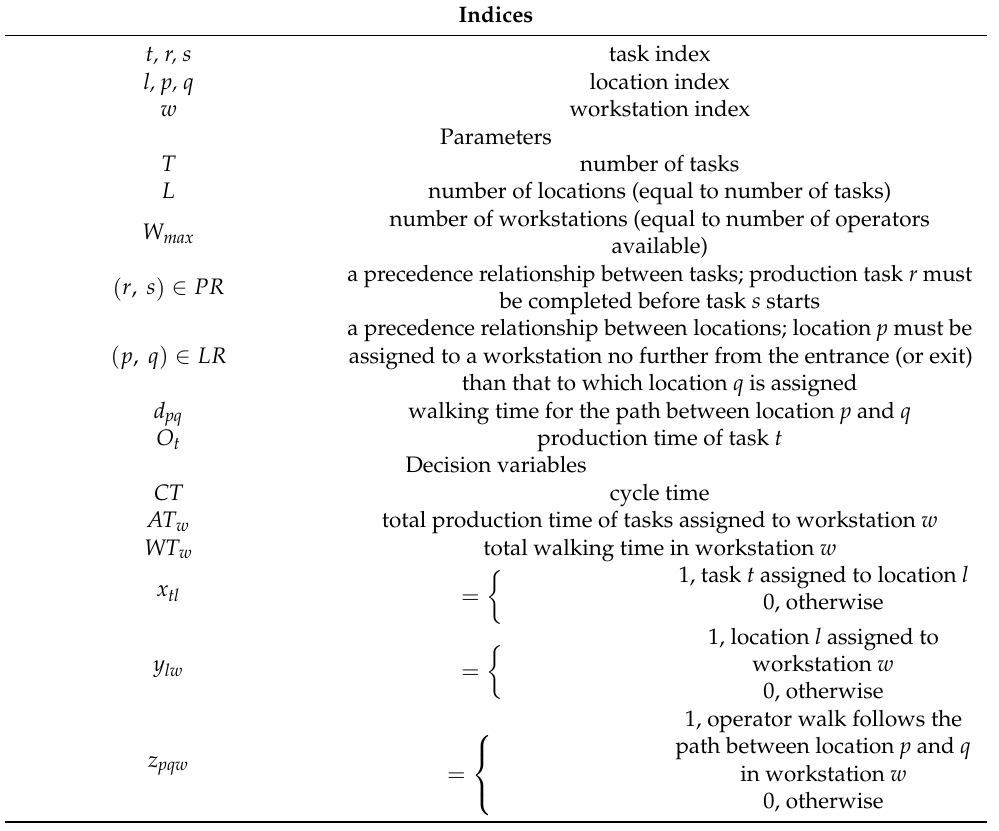
Table 1. Definition of